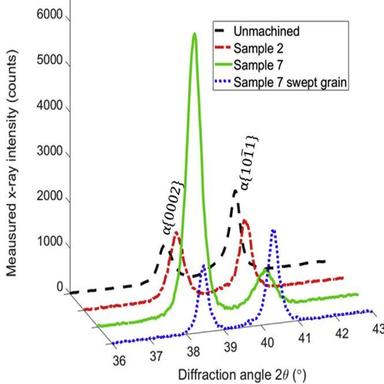
Diffraction patterns from XRD reflection measurements on machined surface samples focusing on the α (0002) and α (101‾1) planes.